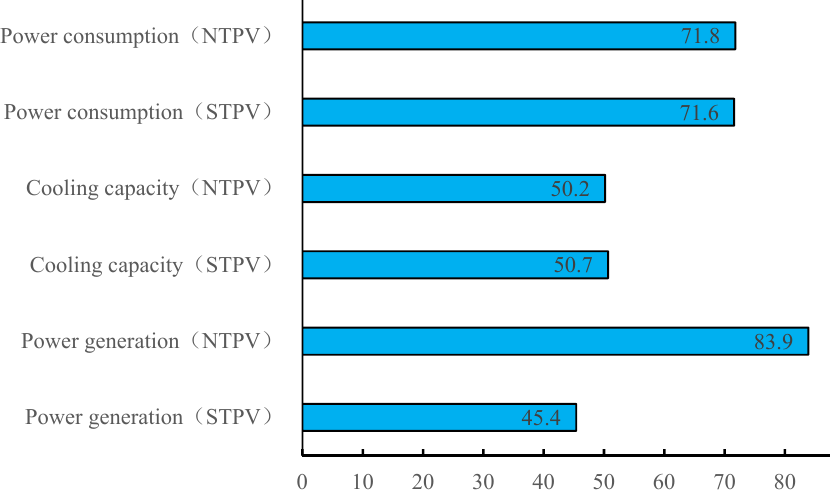
Figure 11. Energy consumption of two types of PV modules.